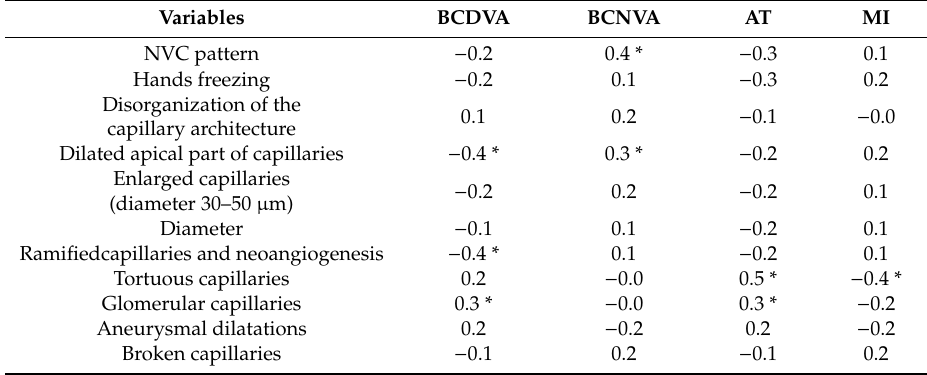
Table 4. Correlation between NVC parameters and functional